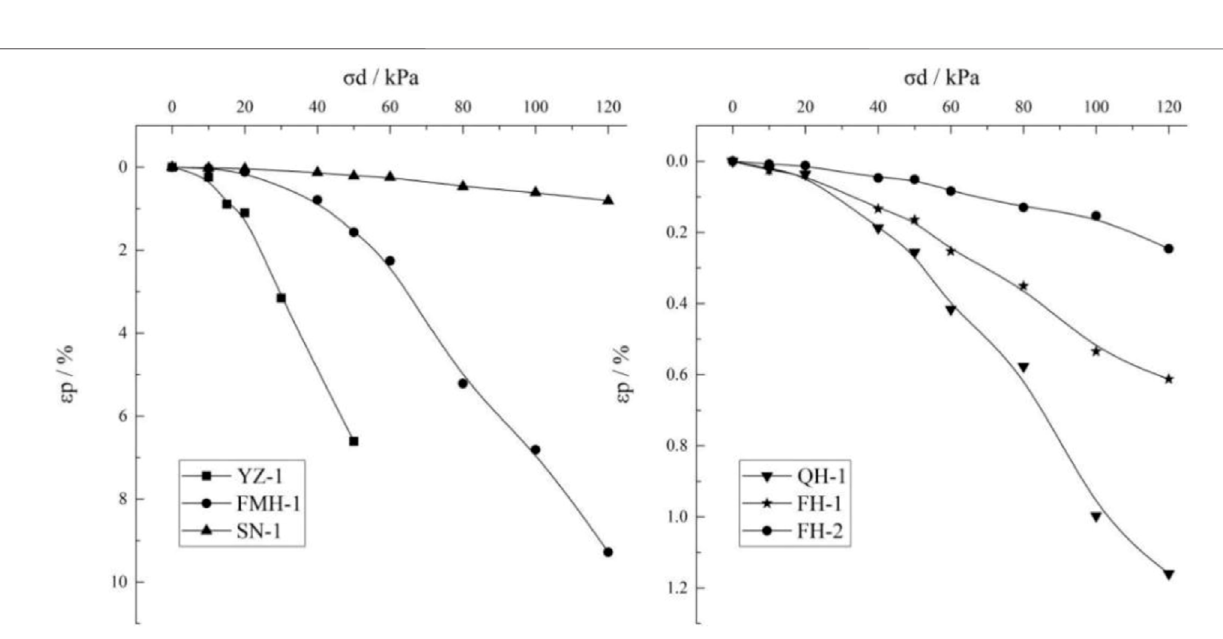
FIGURE 7 | Original and improved loess seismic subsidence curve ( N (cid:2)